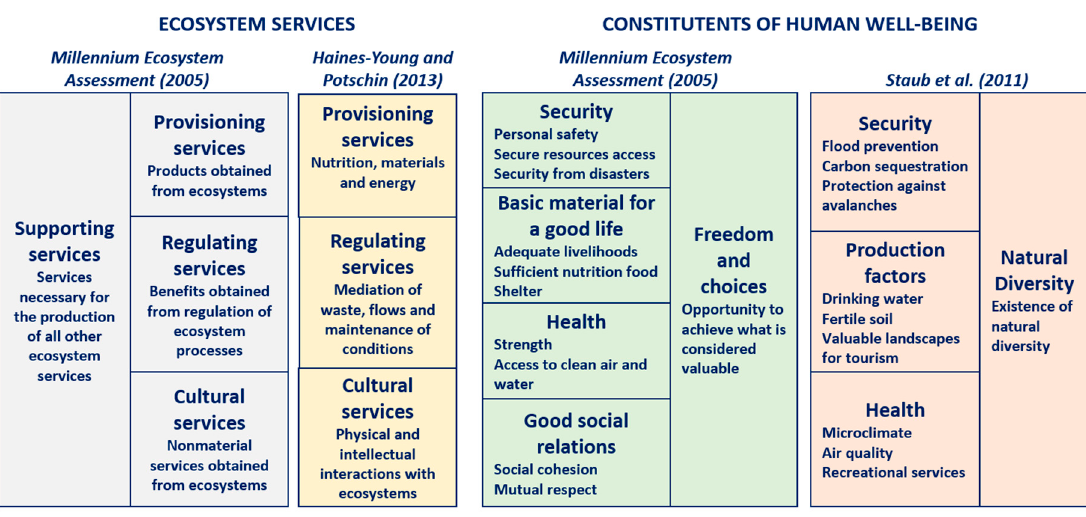
Figure A1. Classification of ecosystem services and components of human well-being according to the Millennium Ecosystem Assessment [23], Haines-Young and Potschin [25], and Staub et al. [27].